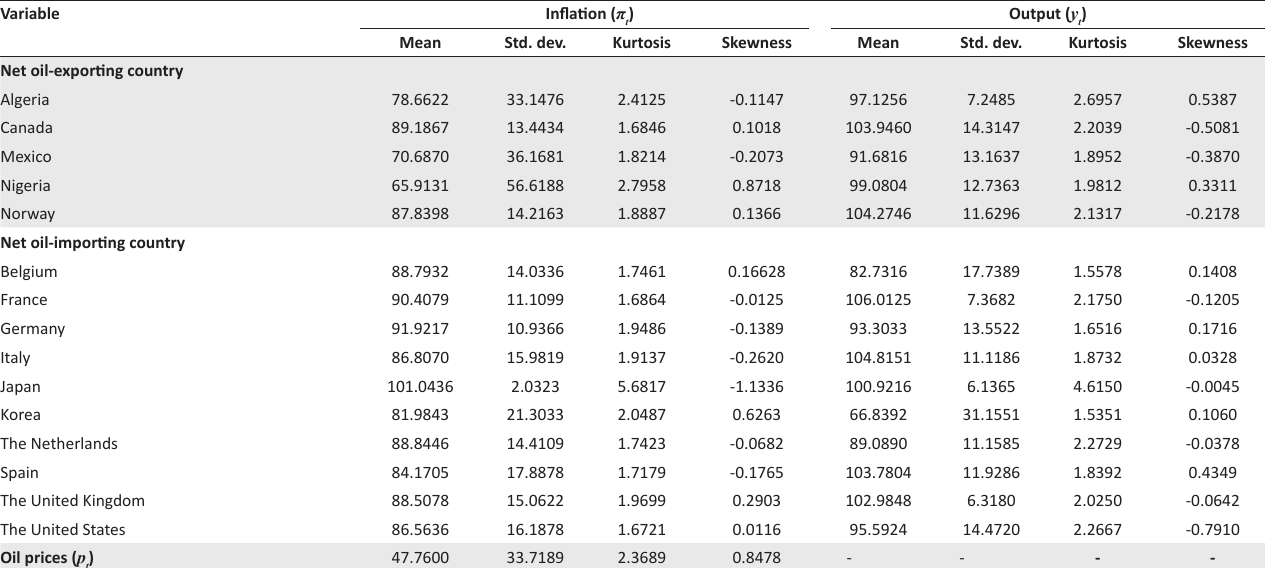
TABLE 1: Descriptive statistics.